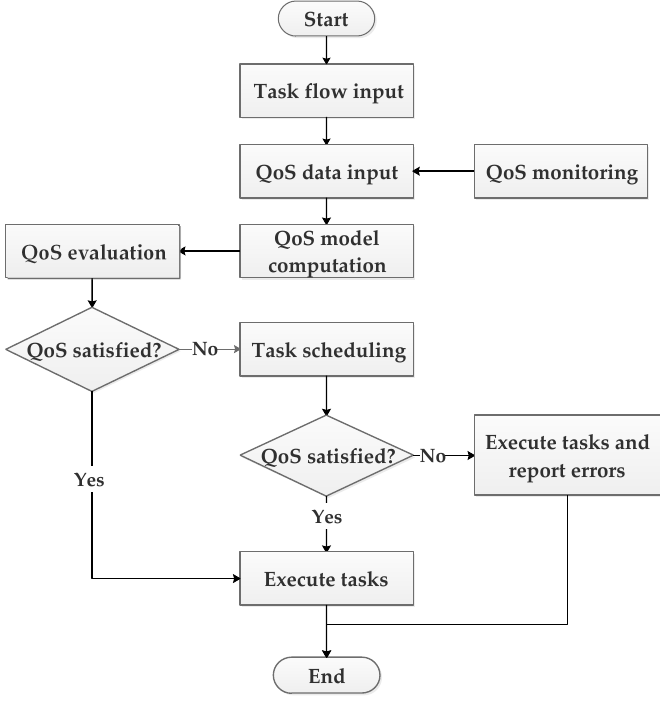
Figure 4. Task execution process based on user QoS